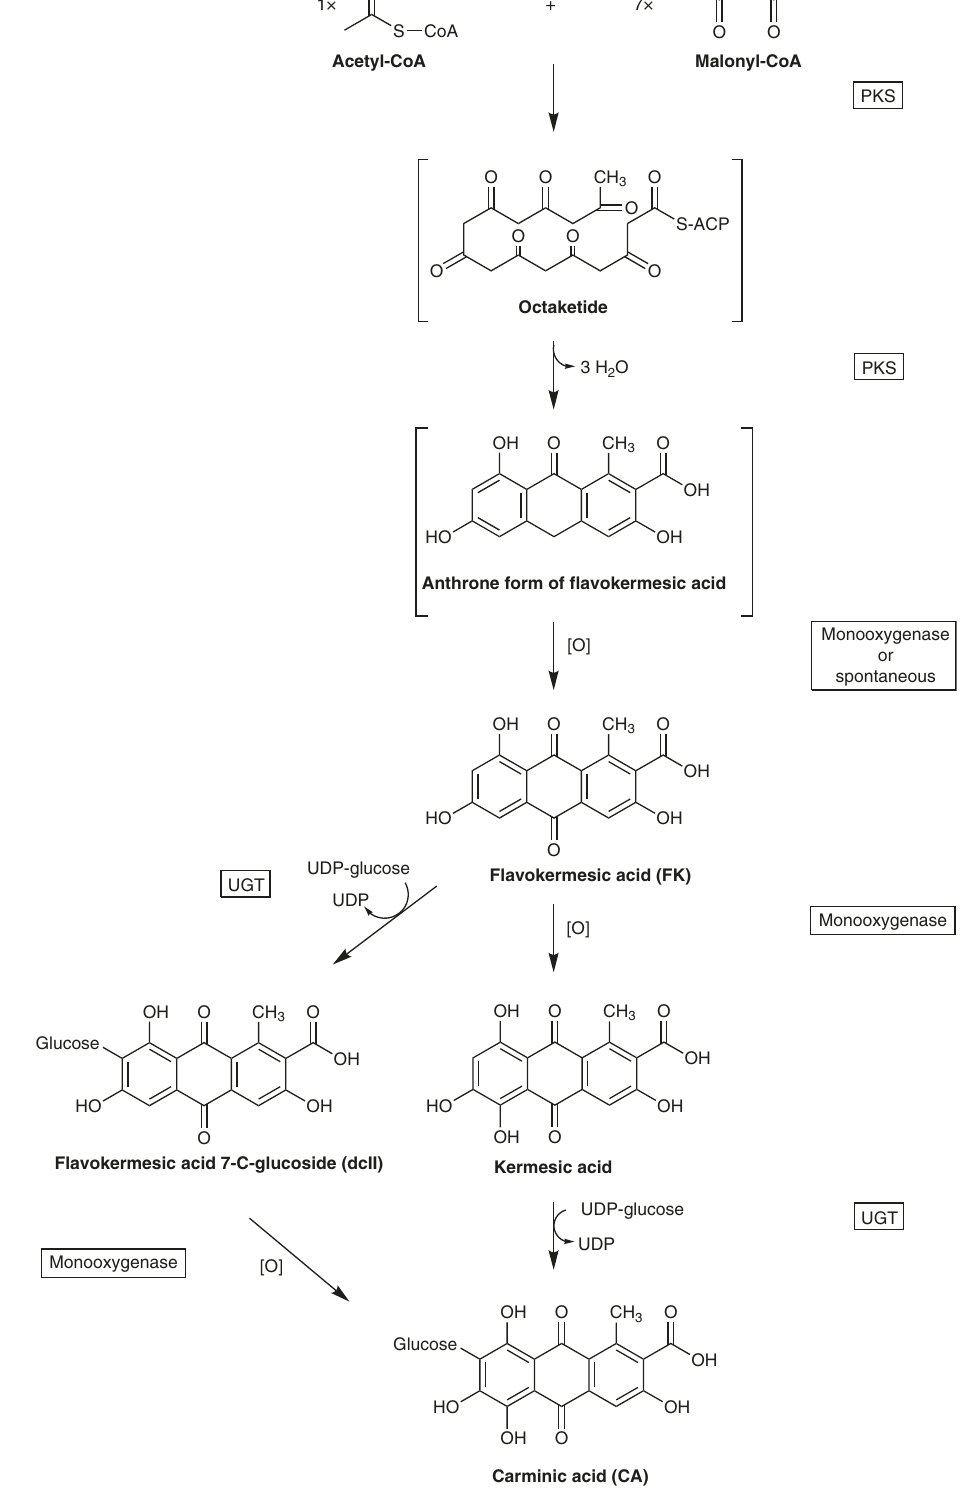
Fig. 1 Putative carminic acid pathway in Dactylopius coccus . UDP uridine diphosphate, UGT uridine diphosphate glucosyltransferase, PKS polyketide synthase, CoA coenzyme A, [O] oxidizing agent, ACP acyl carrier protein NATURE COMMUNICATIONS | 8: